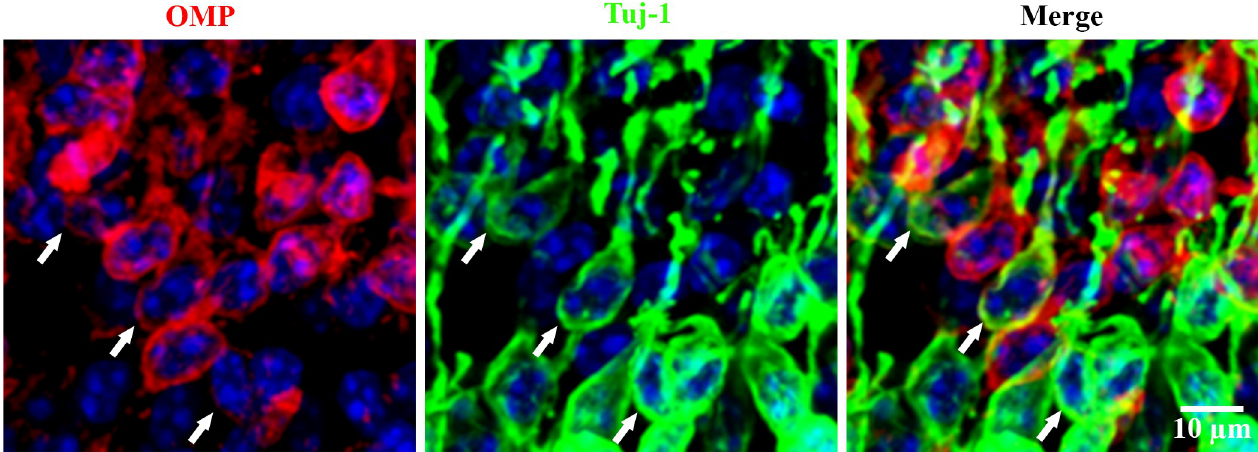
Fig 9. Co-labeling of OMP and Tuj-1 within the soma of the same OSN using IHC on OE cross sections. The detection of both OMP and Tuj-1 in the cytoplasm of the same OSN was rare and the staining of the two markers was not usually superimposed. The images were zoomed from a photo acquired by a confocal microscope with a 60X objective. The arrows indicated the OSNs that co-express OMP and Tuj-1.